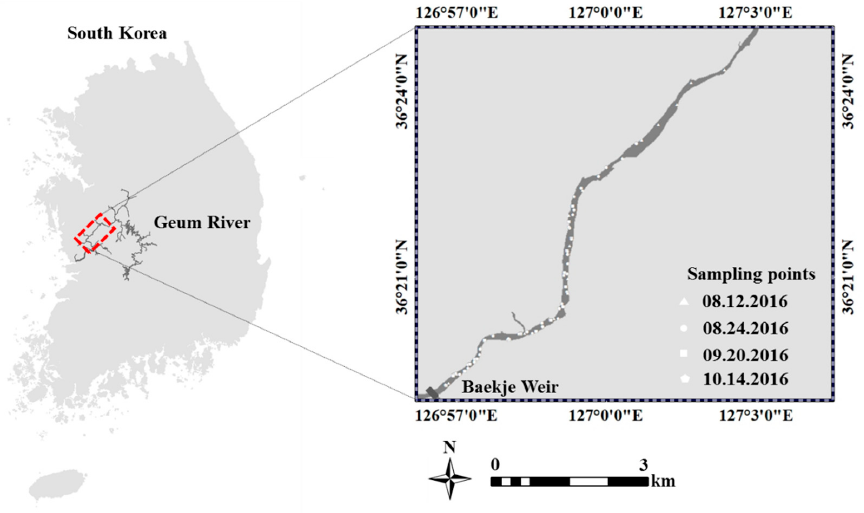
Figure 1. Study site in the Baekje Reservoir region.